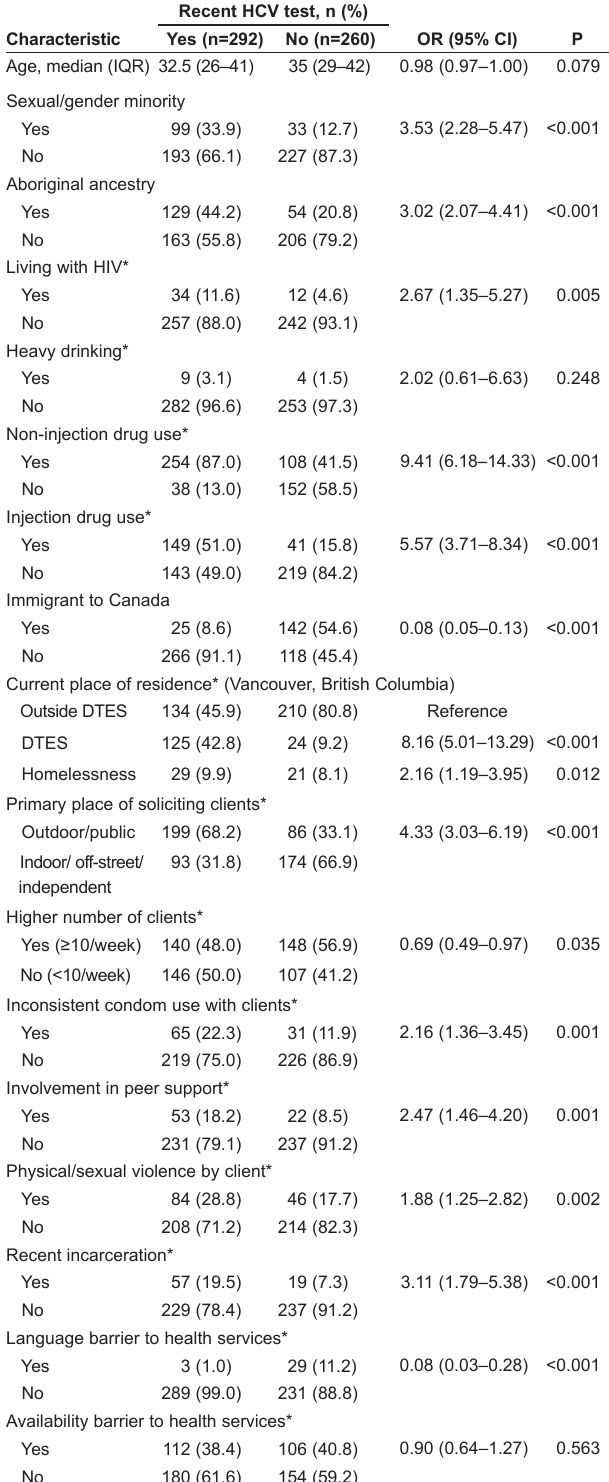
bivariate logistic regression analyses of factors